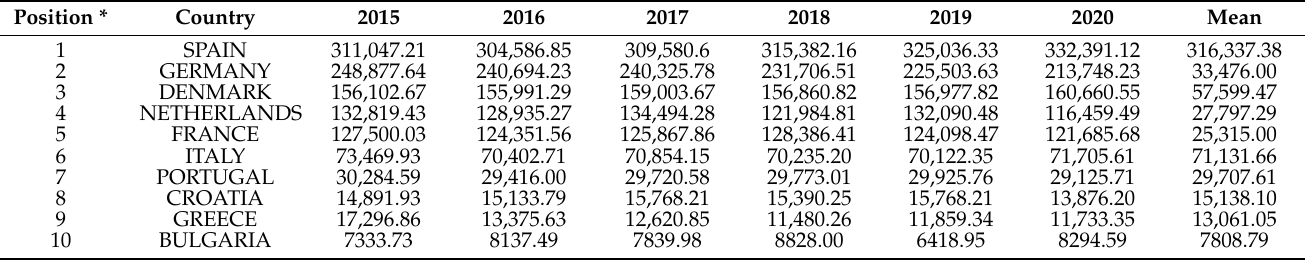
Table 6. Results of CH 4 emissions from manure management using Tier 2 methodology (Gg CO 2 -